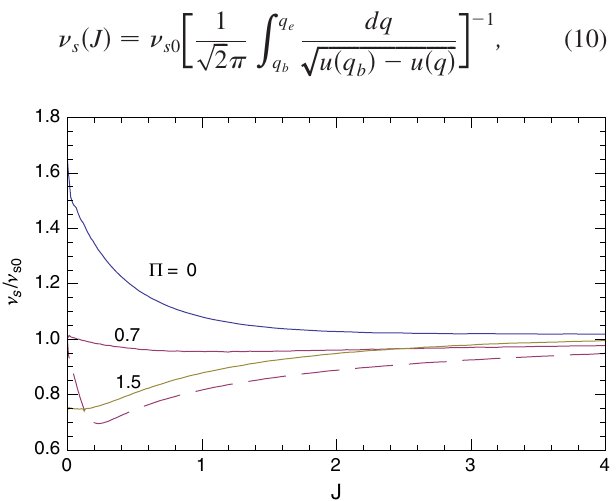
FIG. 7. Shielded CSR: incoherent tune at threshold due to the distorted potential well, as a function of action, J , for cases (cid:1) ¼ 0 , 0.7, and 1.5. The dashed curve is explained in the text